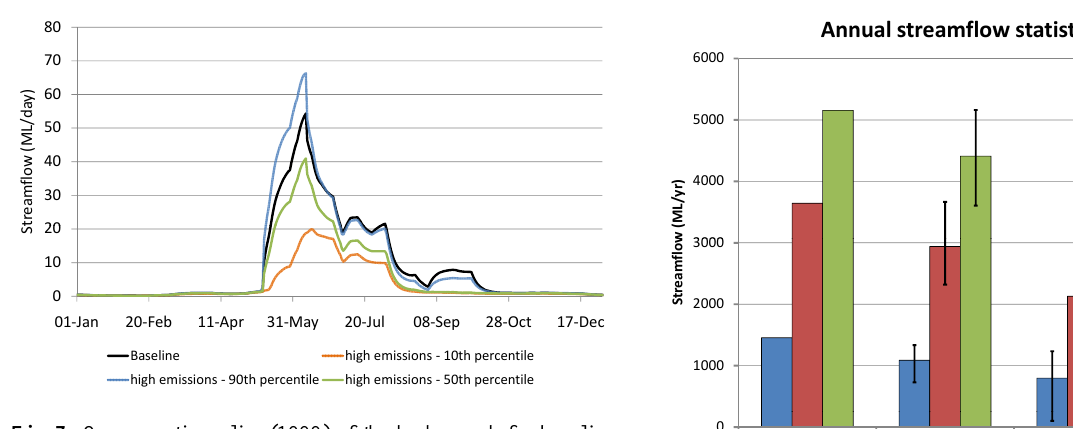
Fig. 7. One year time-slice (1999) of the hydrograph for baseline and high emissions scenario.